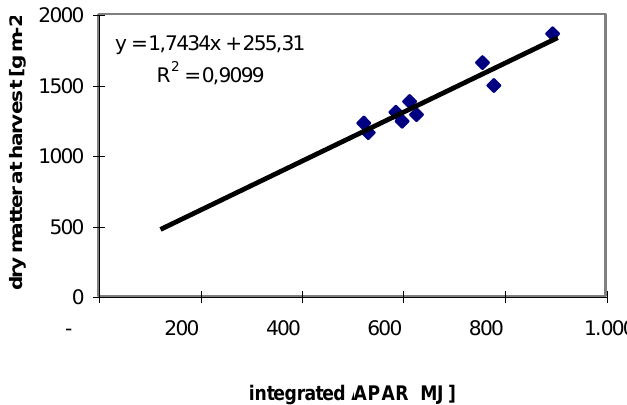
Figure 6. Linear regression between the seasonally (from sowing to harvest) integrated absorbed PAR and dry matter at harvest (g·m −2 ) of nine commercial winter wheat plots from Atzberger